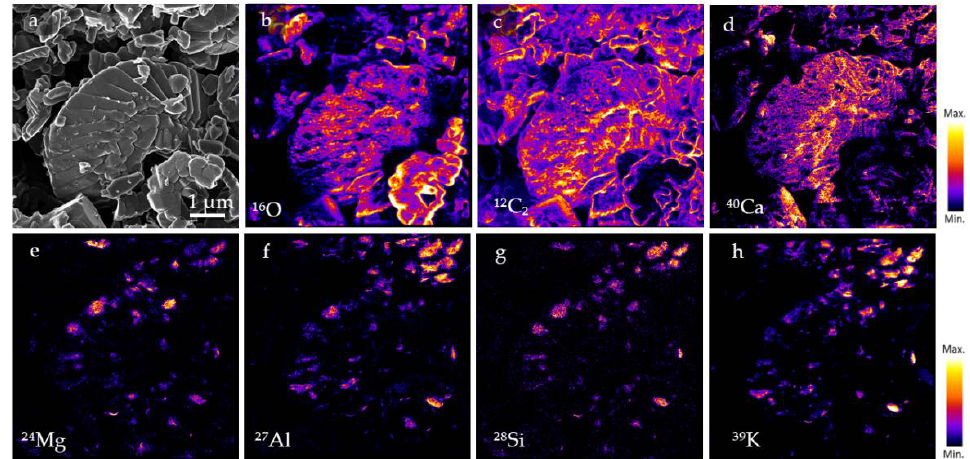
Figure 4. HIM-SIMS images of sample OBSV 12.4. ( a ) SE image of a ROI obtained by HIM focusing on a coccolith fragment. ( b – d ) Chemical images obtained by SIMS of 16 O, 12 C₂, and 40 Ca are presented with a scalebar at the right, representing the intensity of each element. ( e – h ) Elemental distribution of ²⁴Mg, ²⁷Al, ²⁸Si, and ³⁹K.